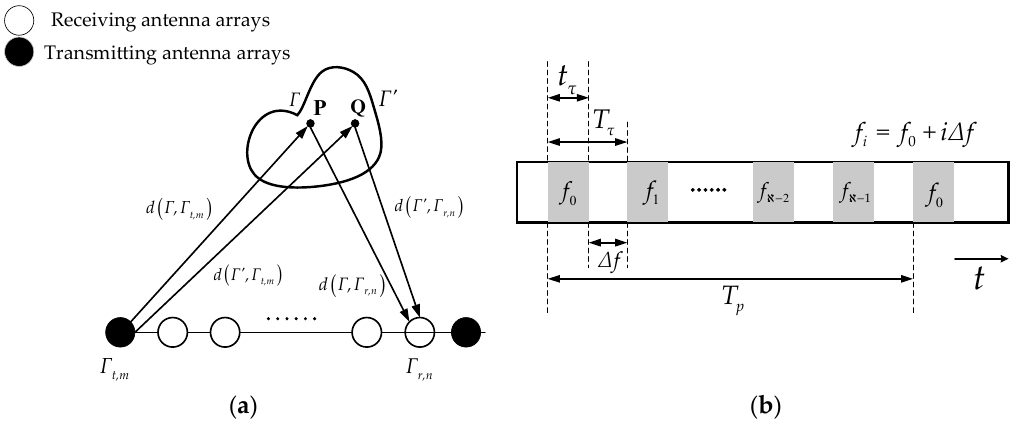
Figure 1. ( a ) Diagram of Multiple-Input Multiple-Output (MIMO) radar system and geometric schematic diagram of back projection (BP) imaging; ( b ) Diagram of the stepped-frequency signal.